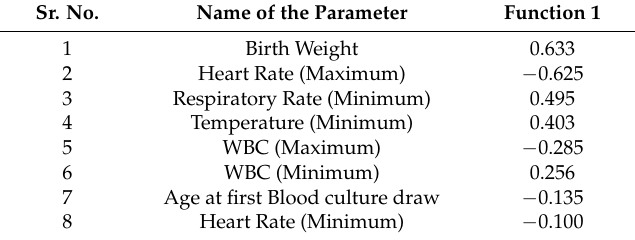
Table 3. Structure matrix showing the predictive power of independent variables. Sr. No. Name of the Parameter